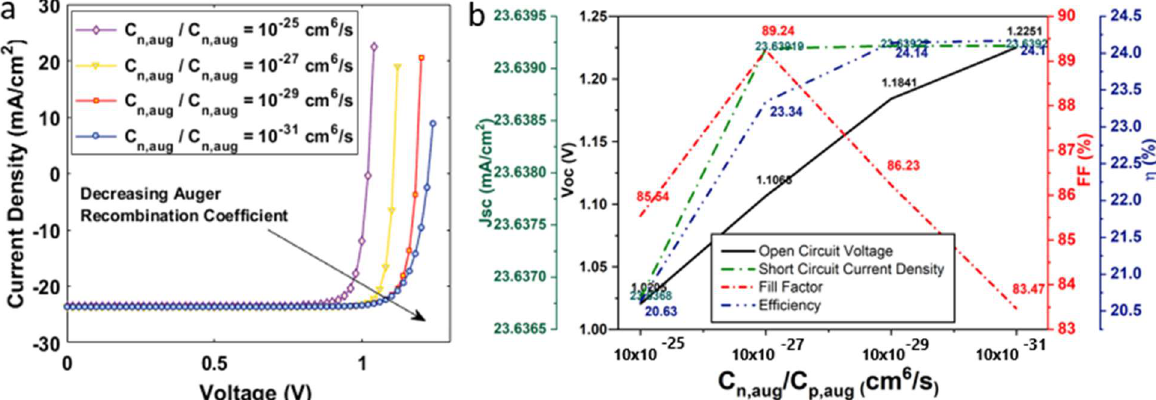
Figure 5. ( a ) Current density–voltage characteristics of a solar cell under auger recombination; ( b ) influence of Auger recombination coefficient on the open circuit voltage, short circuit current density, fill factor, and efficiency of the solar cell.